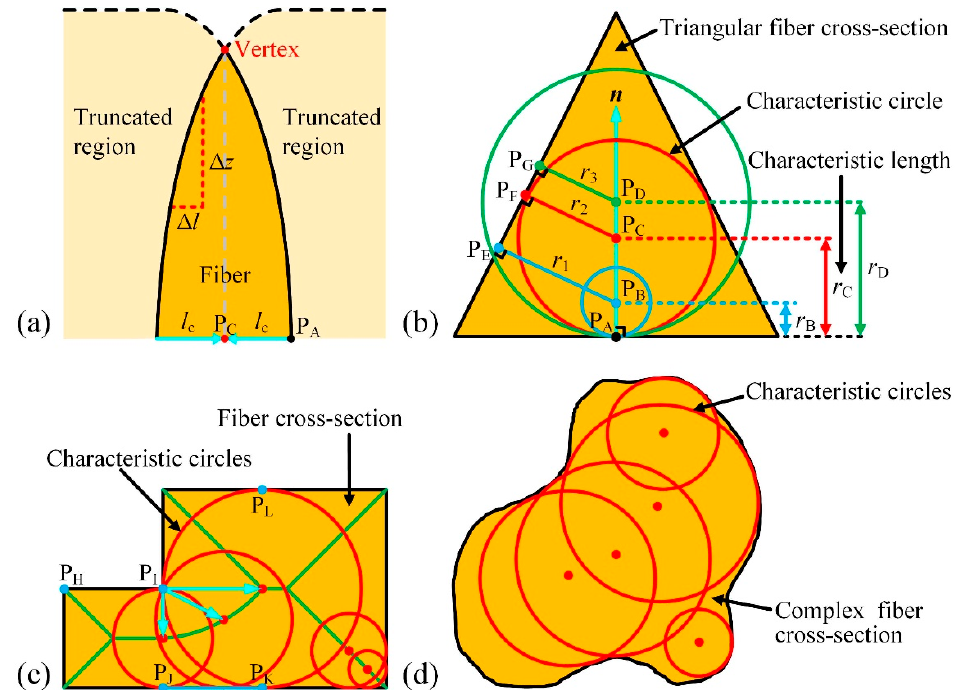
Figure 4. Schematic diagram for the characteristic lengths and circles of each point: ( a ) factor limiting fiber morphology; ( b ) selection of the suitable characteristic lengths and circles; ( c ) discussion on two singular points; ( d ) characteristic circles and centers of a concave complex fiber cross section.